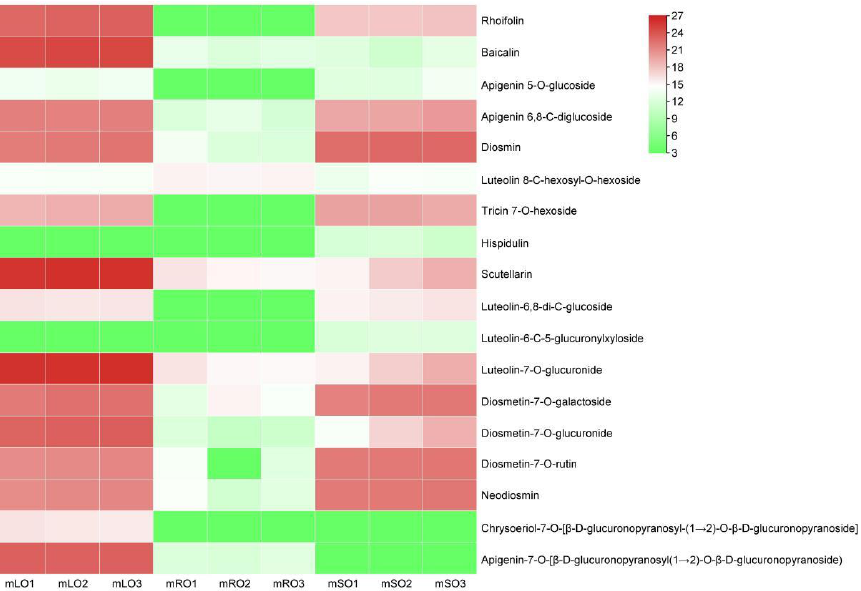
Figure 11. Flavonoid types and content heat map. Mature root, stem, and leaf samples are represented by mRO, mSO, and mLO, respectively. The flavonoid content in the heatmap is log2 processed.